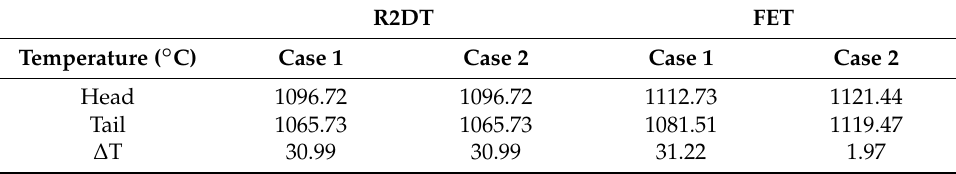
Table 4. Numerical data for the upper surface of the transfer bar with the acting-type heat retention panel.